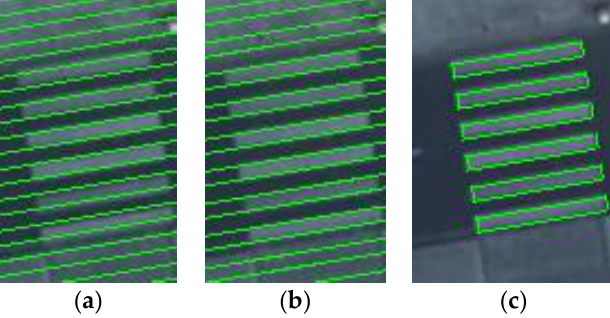
Figure 14. ( a ) Two groups of edge lines before optimization; ( b ) Lines after optimization; and ( c ) An